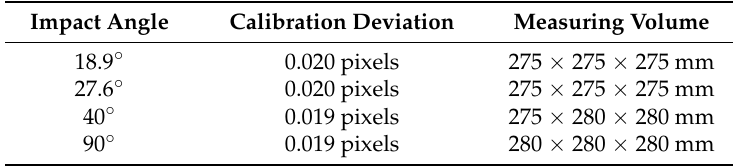
Table 2. GOM calibration